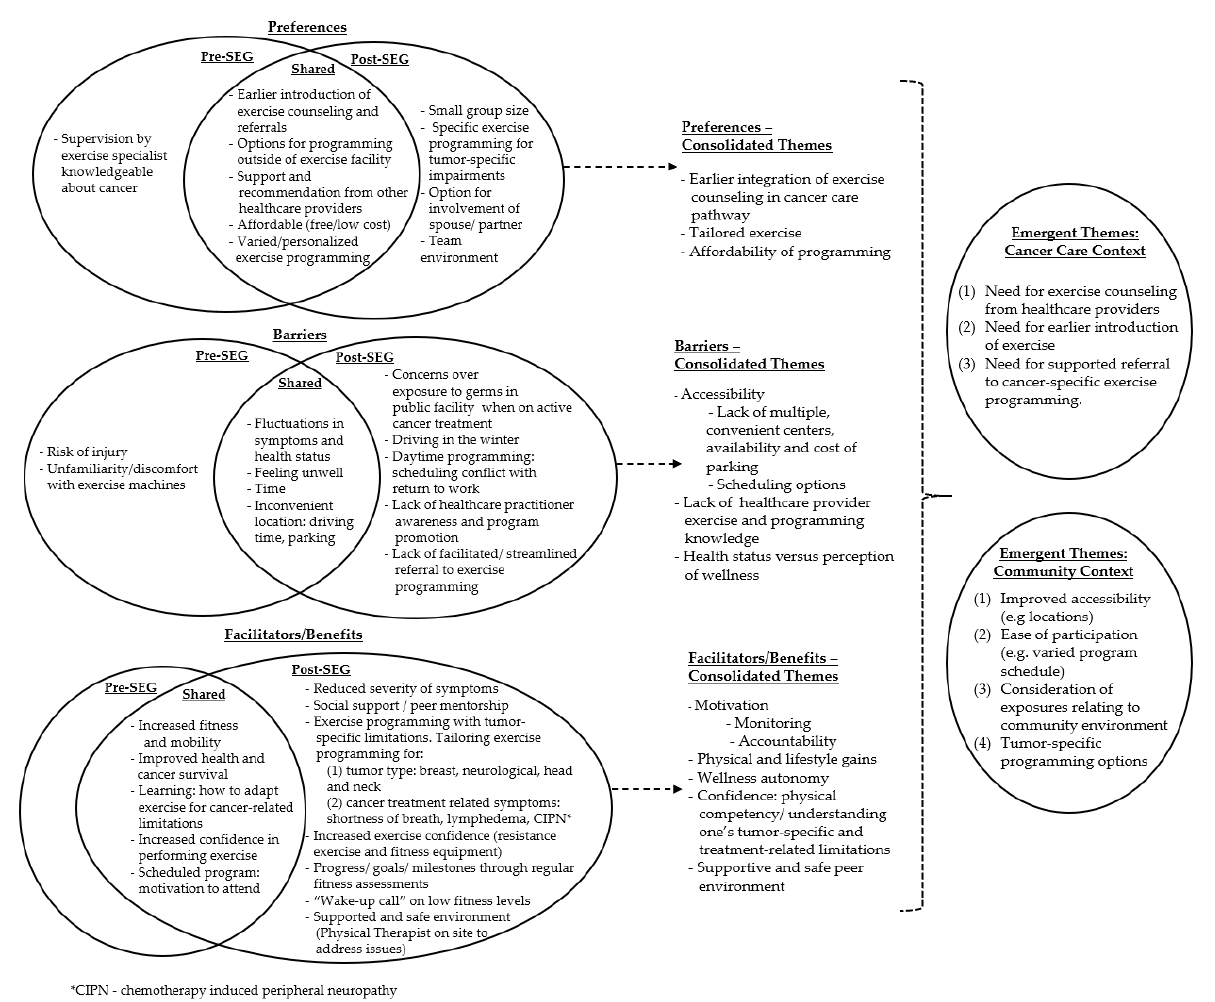
Figure 2. Framework analyses of preferences, barriers and facilitators / benefits pre- and post-stakeholder engagement groups to reach common themes.